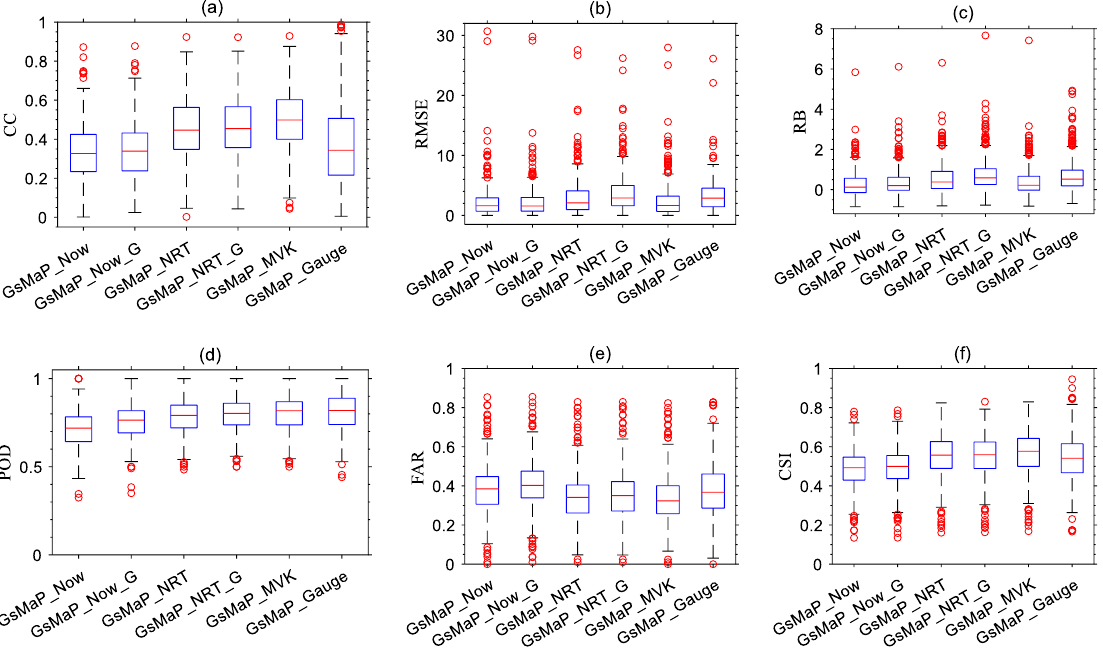
Figure 8. Boxplot of CC ( a ), RMSE ( b ), RB ( c ), POD ( d ), FAR ( e ), and CSI ( f ) for hourly GSMaP data for all RG’s stations. Table 6. The mean of validation data matrix for daily data for all stations.